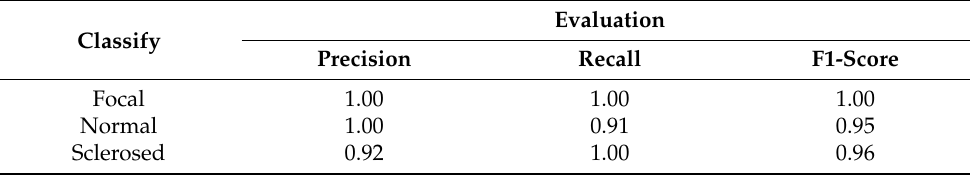
Table 8. Classification of the multivariate model.